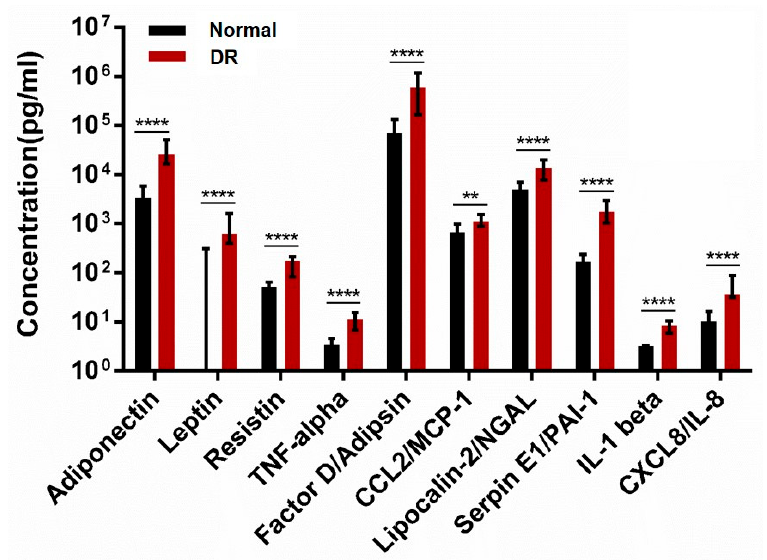
Figure 2. Adipokines levels between the normal and DR groups. The data were compared using Student’s t-test and differences were considered significant when, ** for p < 0.01., **** for p < 0.0001.